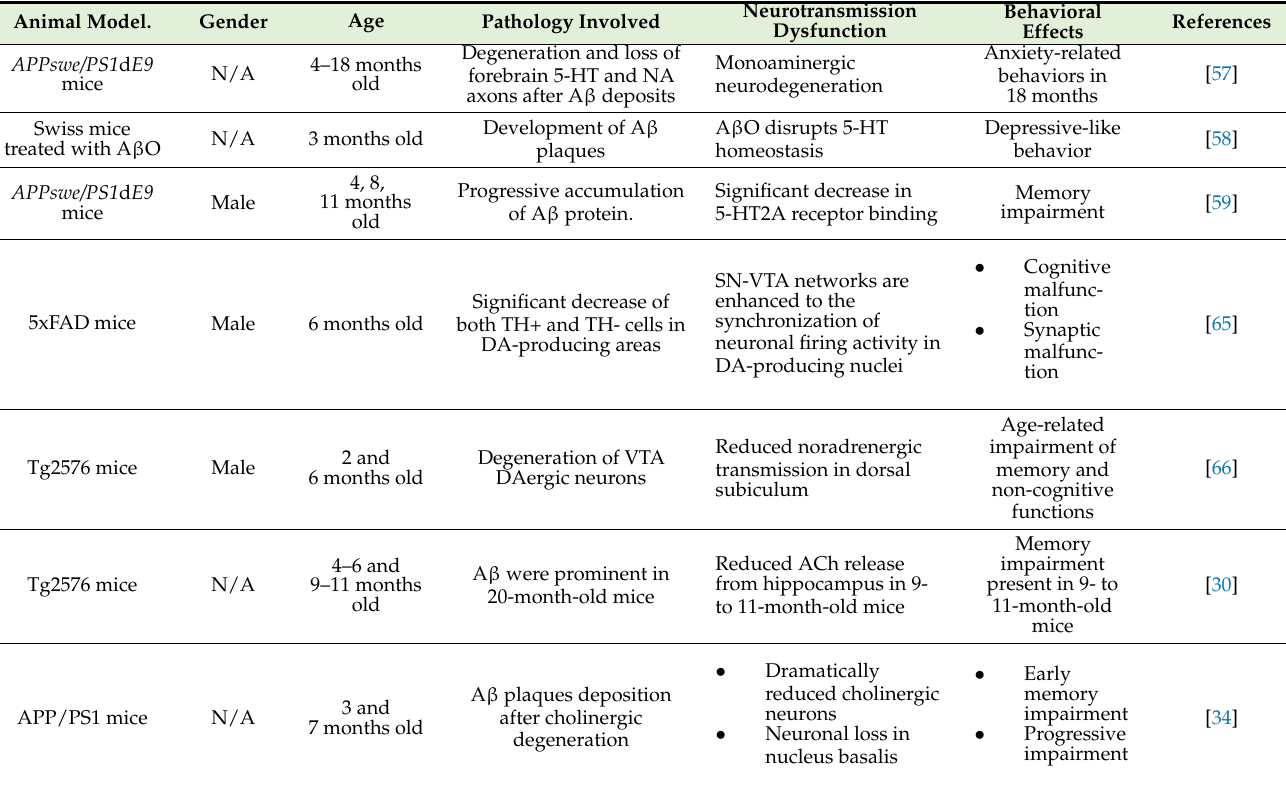
Table 1. In vivo studies related to neurotransmission in AD. Abbreviations : 5 HT, 5-hydroxy-tryptamine, Serotonin; ACh, Acetylcholine; AChE, Acetylcholinesterase; APPswe, Amyloid-beta precursor protein with Swedish mutation; A β , Amyloid-beta; A β O, Amyloid-beta oligomers; A β PP, Amyloid-beta precursor protein; ChAT, Choline acetyltransferase; DA, Dopamine; DAergic, Dopaminergic; GABA, Gamma-aminobutyric acid; MAergic, Monoaminergic; mGlu2, Metabotropic glutamate receptor 2; NA, Noradrenergic; NMDAR, N-methyl-D-aspartate receptor; PS, presenilin transgenic; SN, Substantia nigra; TH-, Tyrosine hydroxylase negative; TH+, Tyrosine hydroxylase positive; VTA, Ventral tegmental area. Animal